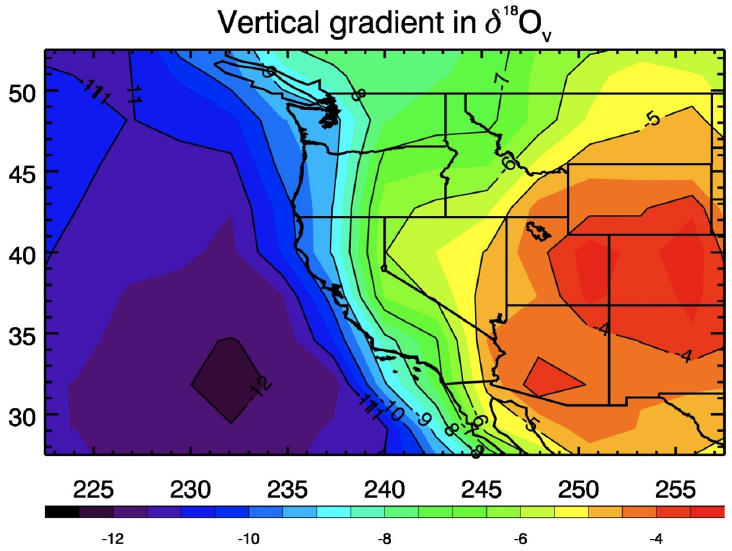
Figure 8. Difference between the isotopic composition of vapor between vertical tags 3 and 5 (Figure 7e and Figure 7c). More negative values indicate a steeper veritcal gradient in δ 18 O values of vapor ( δ 18 O ). Closed contour intervals are 0.5‰. v